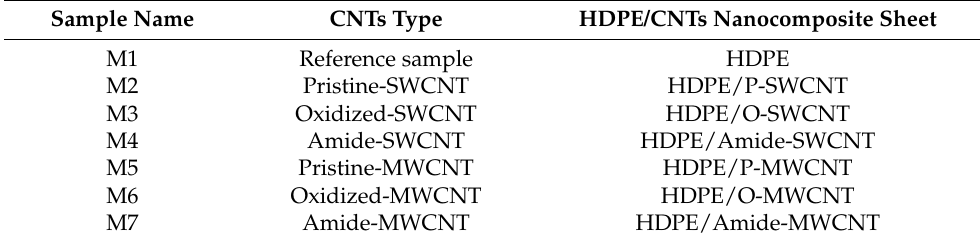
Table 1. Summary of the prepared HDPE/CNTs nanocomposite